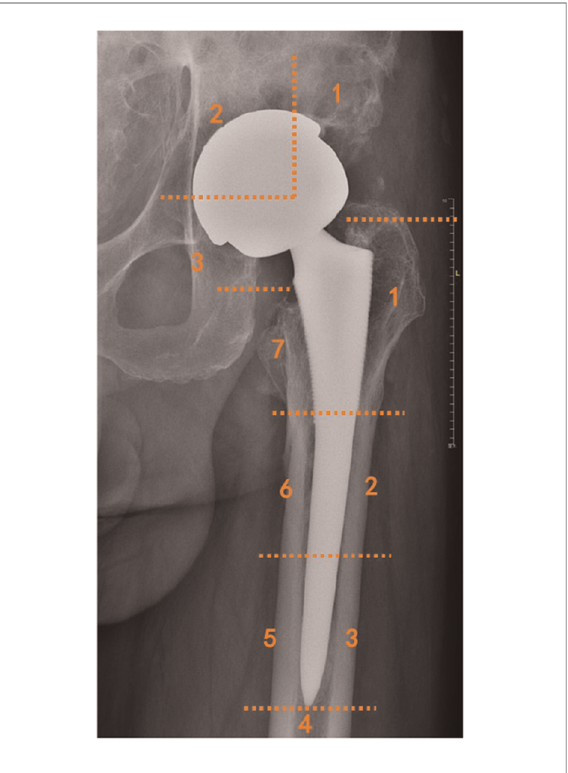
FIGURE 3 Illustration of femoral and acetabular zone classi fi cation by Gruen and by DeLee and Charnley.